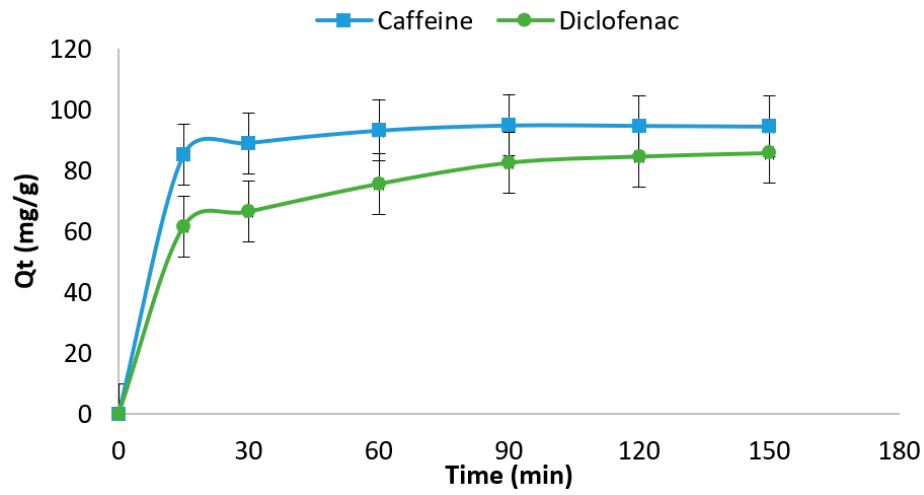
Figure 6. Adsorption of Dic and Caf onto AC based on argan nutshells at different temperatures (C o = 100 mg/L; m = 1 g; T = 30 °C; agitation speed = 200 rpm).